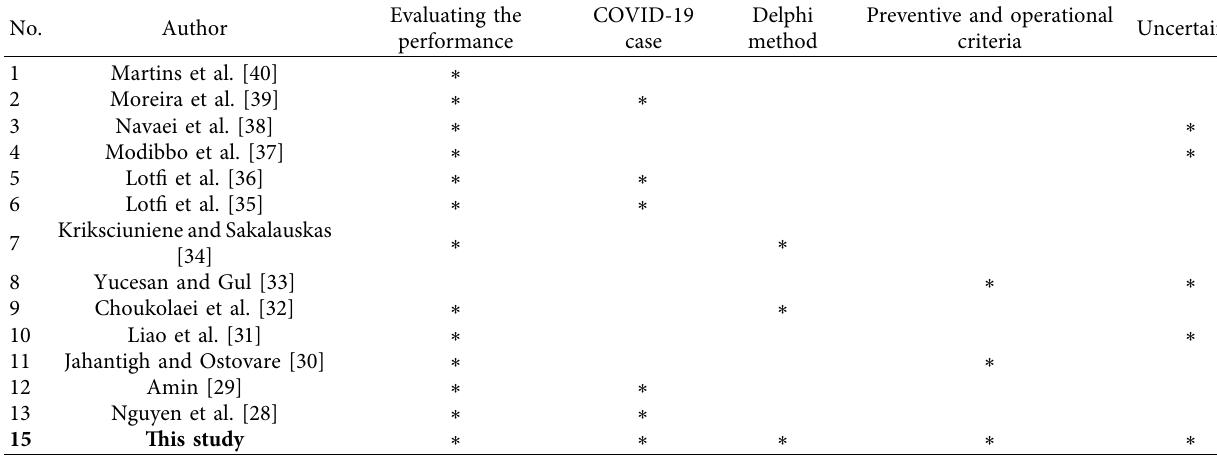
Table 1: Literature review.